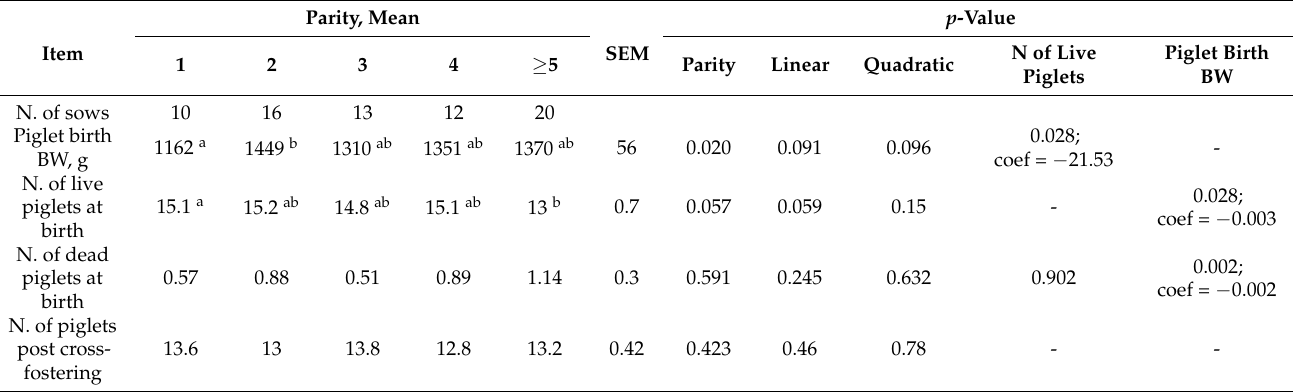
Table 3. Effect of sow parity on sow performance at